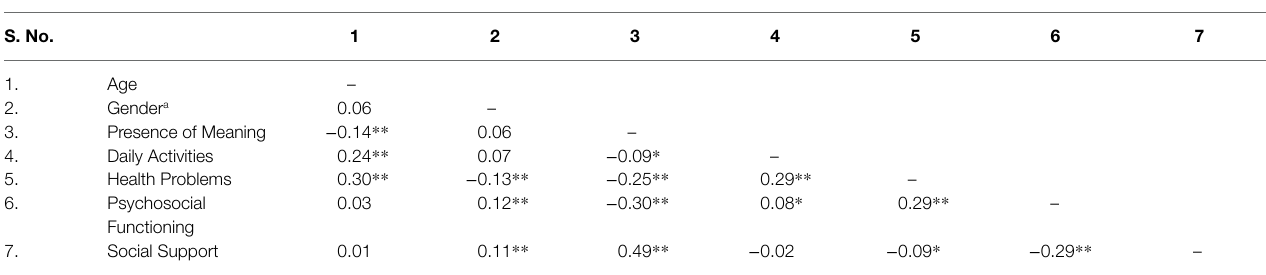
TABLE 2 | Correlations among the study variables.